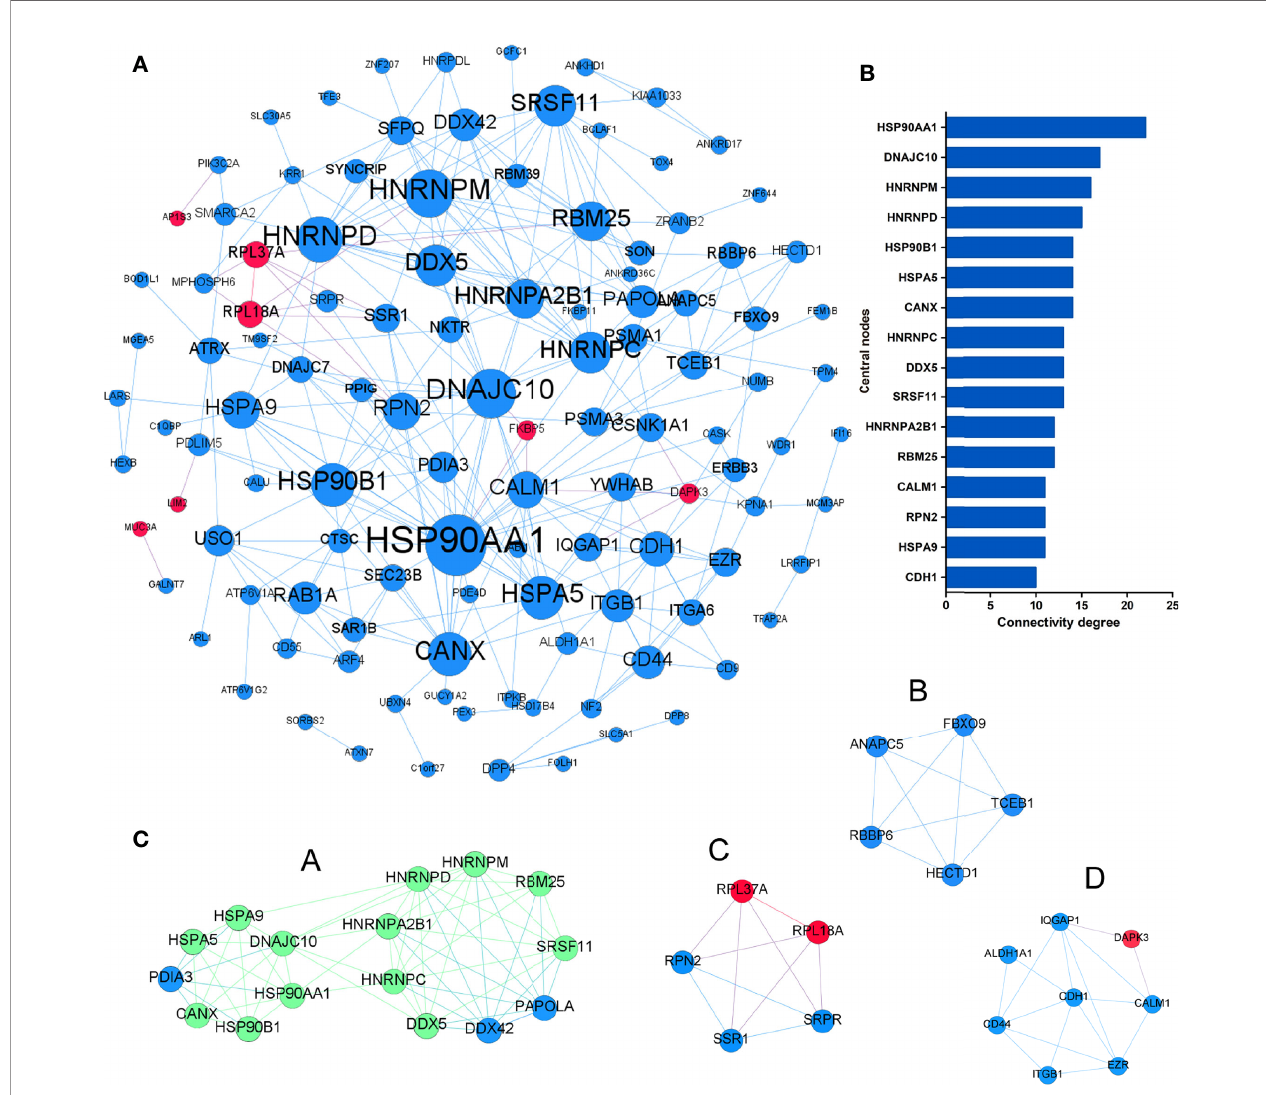
FIGURE 3 | Protein-protein interaction network of the common differentially expressed genes (DEGs) set. (A) The protein-protein interaction (PPI) network was visualized using Cytoscape software. The node size was proportional to the connectivity degree. The genes with no connectivity were not present in the network. (B) A total of 16 central node genes were screened out with the criteria of fi ltering degree ≥ 10 from the PPI network complex. (C) Module a, module b, module c, and module d were regarded as signi fi cant modules with the selection criteria of MCODE score > 3 and node number > 4. Red indicates that the expression of genes is relatively upregulated, and blue indicates that the expression of genes is relatively downregulated. In the module a, green indicates that the common genes present in 16 central nodes and module a were selected as hub